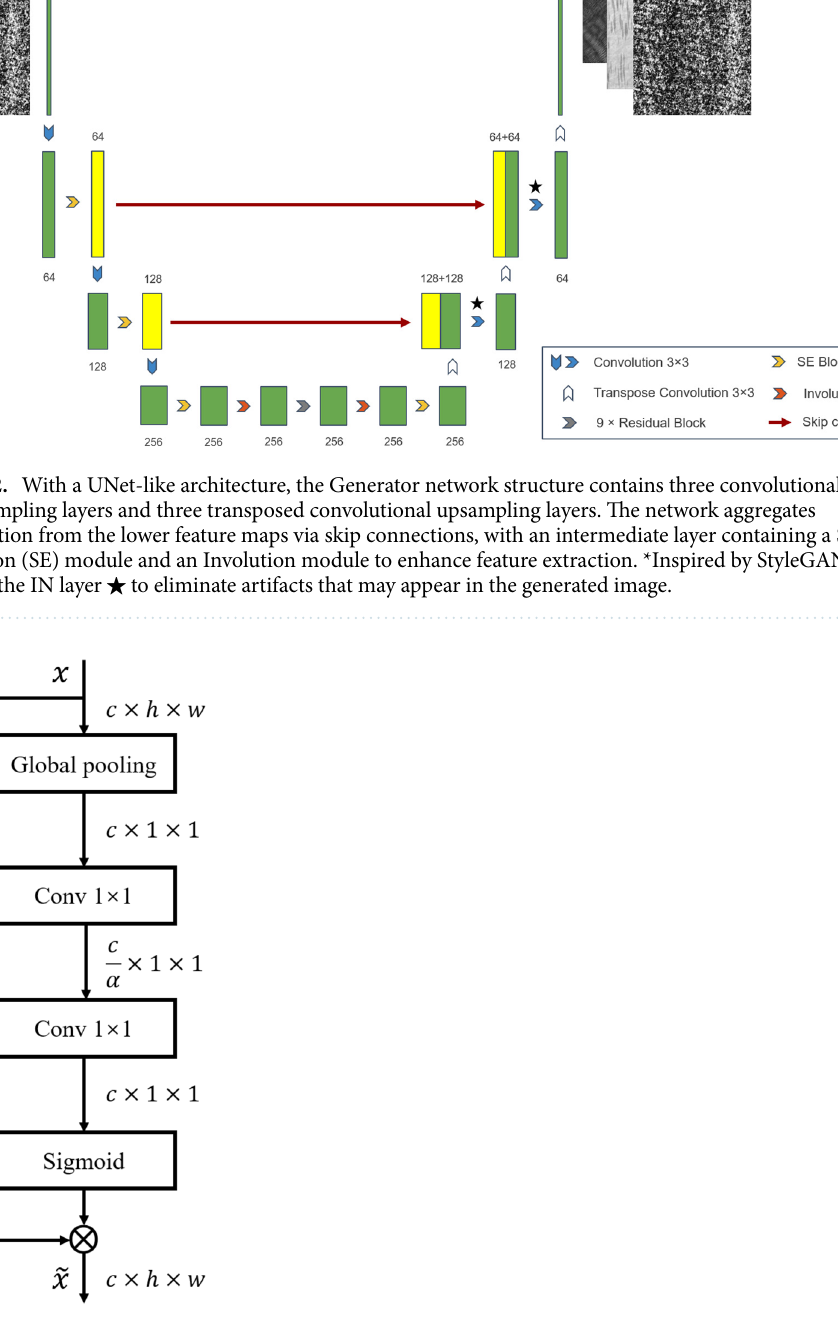
Figure 3. Structure of SE module. α is the channel downsampling ratio and ⊗ denotes the tensor multiplication